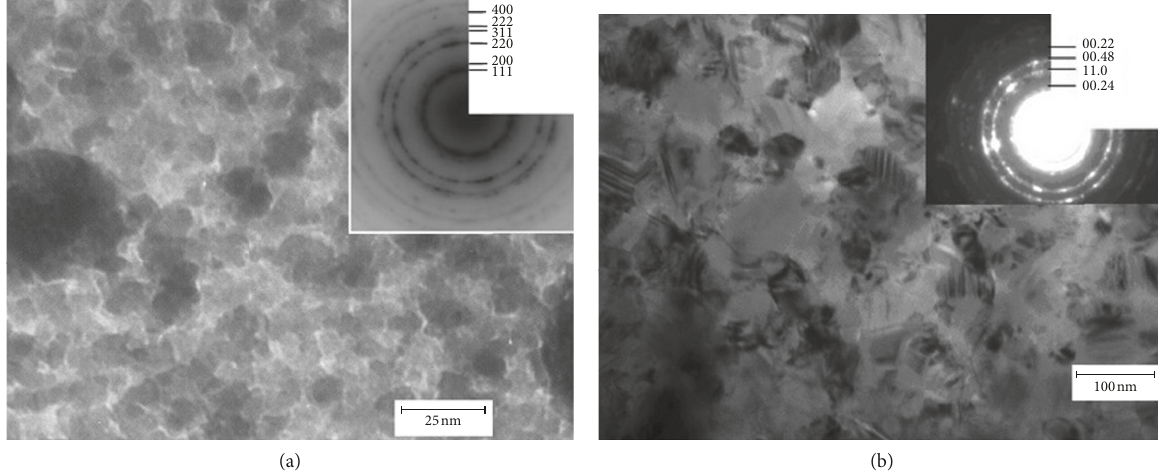
Figure 2: TEM images and SAED patterns of A (a) and C (b) films.